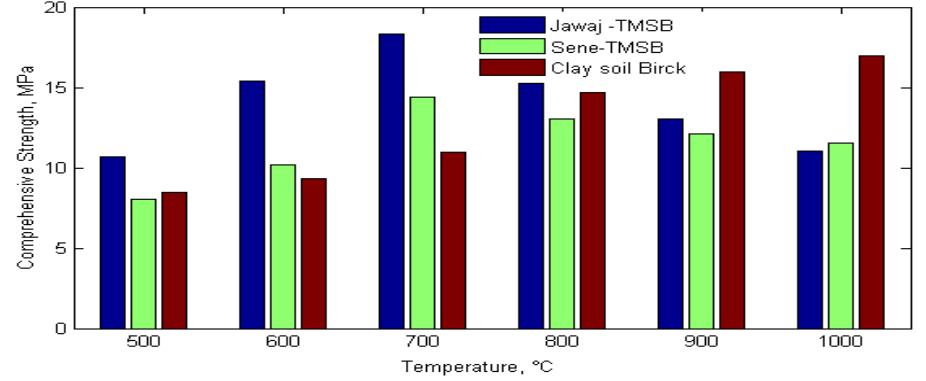
Figure 7: Compressive strength of TMSs bricks and clay soils bricks at different firing temperatures.